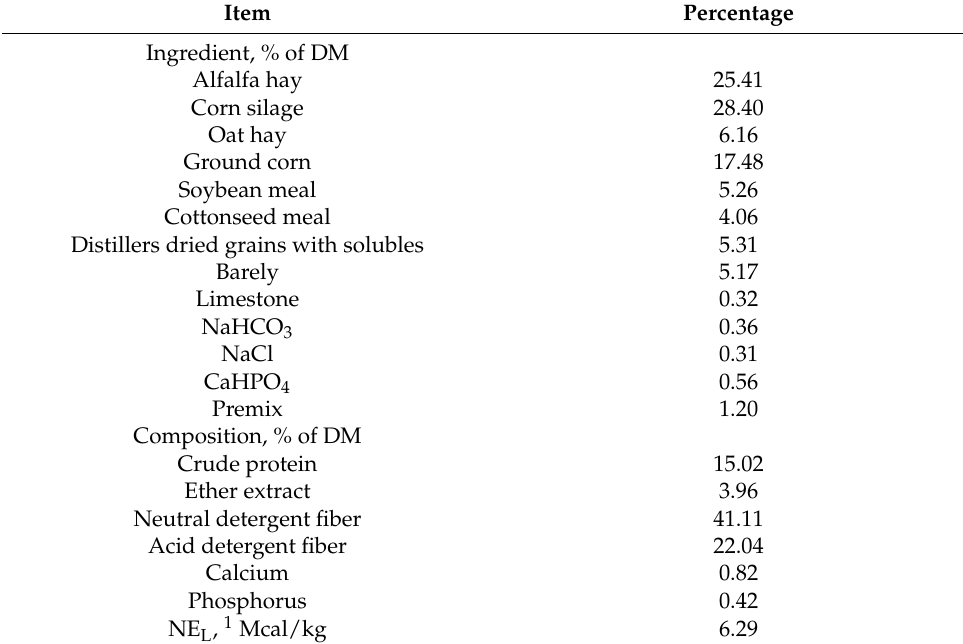
Table 1. Ingredients and nutrient composition of the diet (dry matter